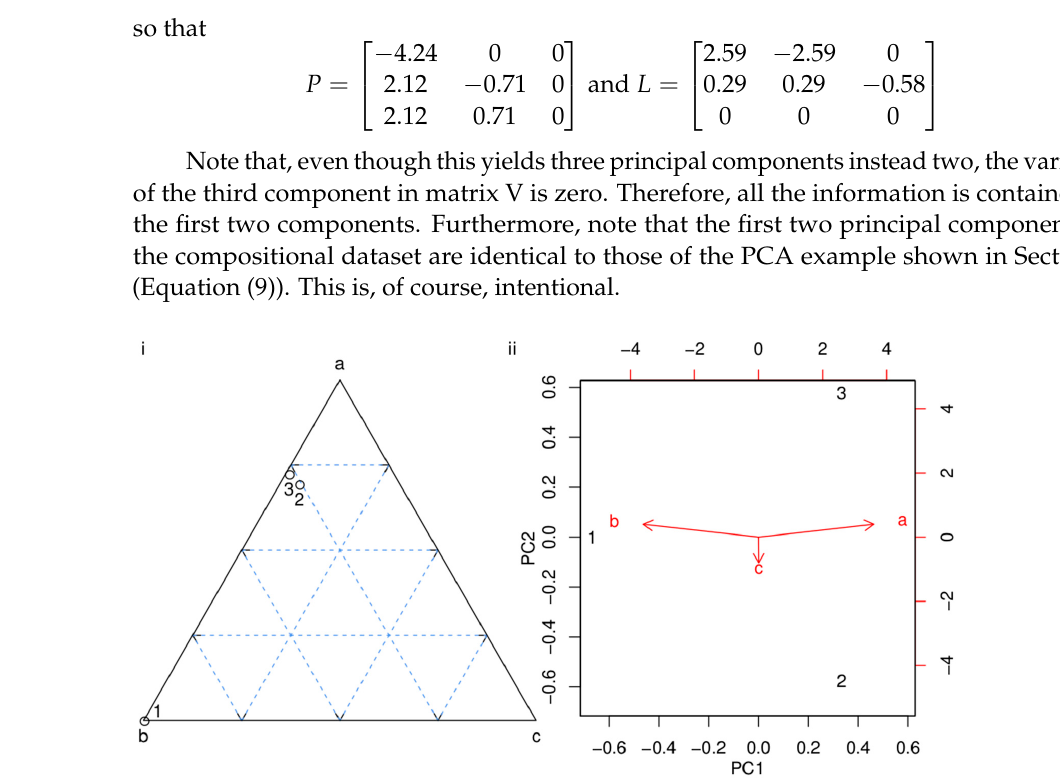
Figure 5. ( i )—the compositional dataset of Equation (14) shown on a ternary diagram; ( ii )—principal component biplot of the same data after centred logratio (clr) transformation.